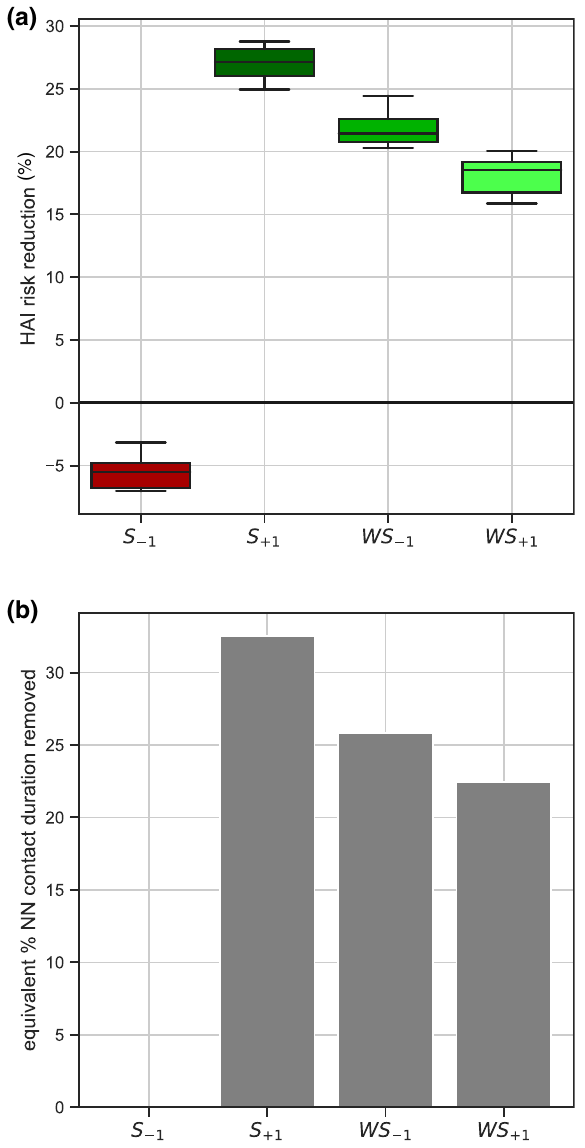
Figure 6. Impact of intervention through reorganization of nurse scheduling. ( a ) HAI risk reduction in the hospital ward achieved with the reorganization of nurse scheduling in the models S − 1 , S + 1 , WS − 1 , WS + 1 , compared to the empirical situation. Boxplots indicate the median, interquartile range and 95% CI of the risk reduction, accounting for the stochasticity of the exchange (results from 50 random trials). ( b ) Percentage of contact duration to be removed in the nurse-nurse interactions so that the intervention through contact removal would achieve the same risk reductions of panel ( a ) (obtained through the reorganization of nurse scheduling). S − 1 is not shown as it has a negative impact on the